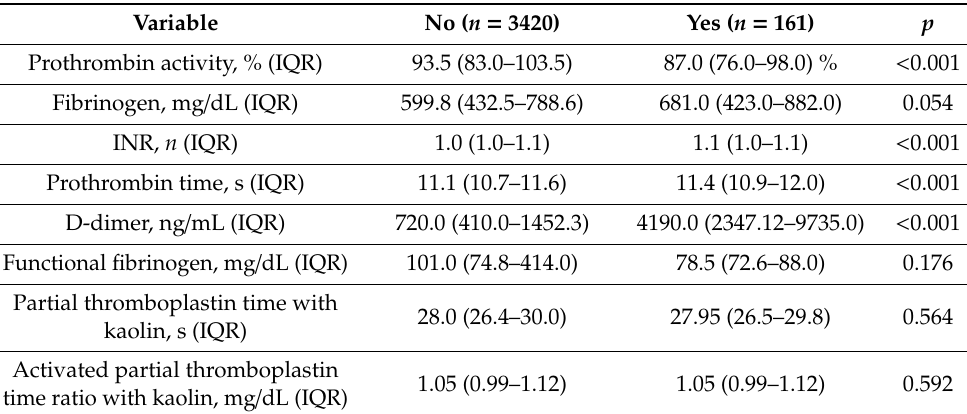
Table 3. Intensive Care Unit Admissions.